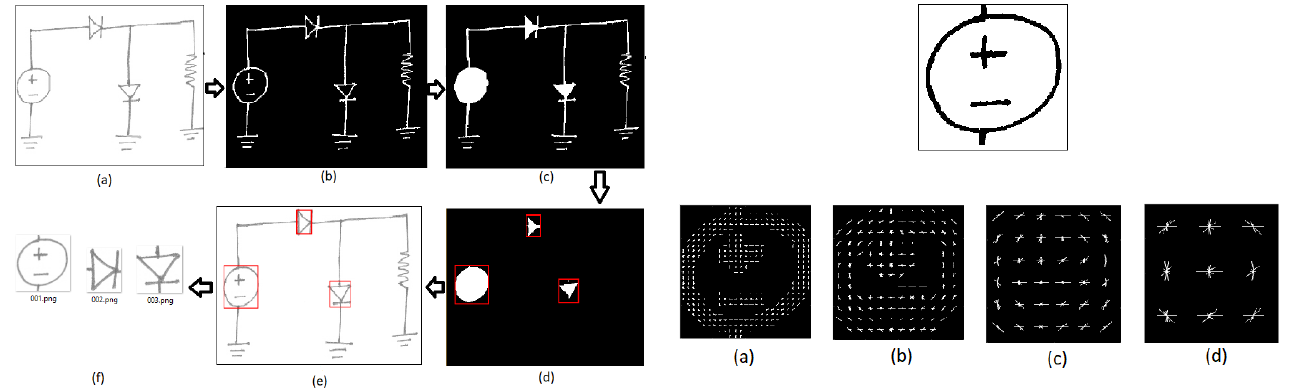
Figure 6. Visualization of HOG features of DC voltage: (a) Feature vector of length 34596 at 8x8 (b) Feature vector of length 8100 at 16x16 (c) Feature vector of length 1764 at 32x32 (d) Feature vector of length 324 at